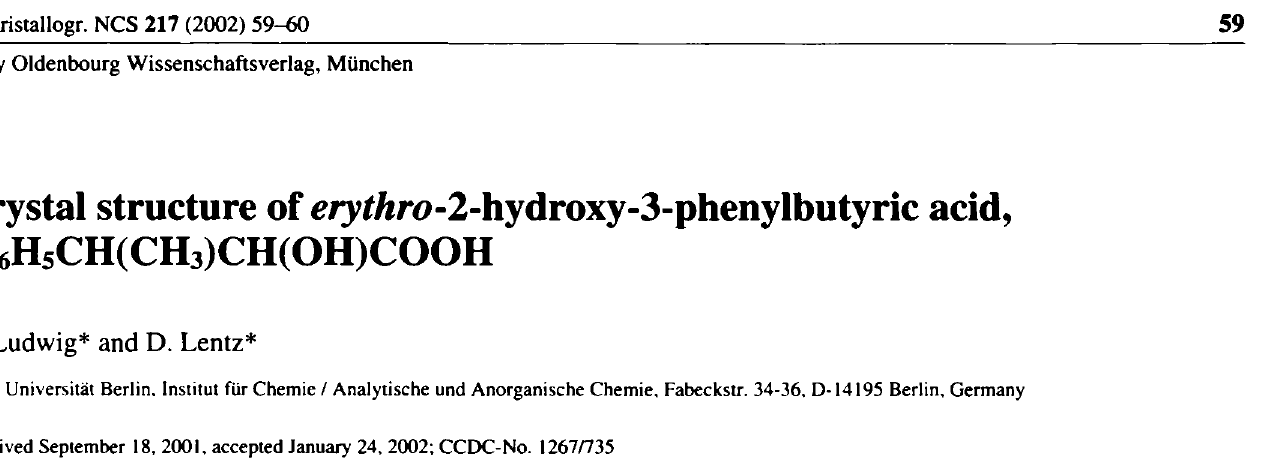
Table 1. Data collection and handling.